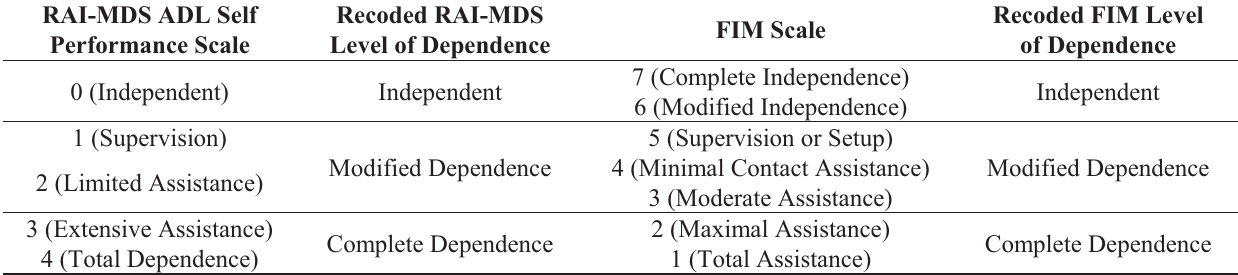
Table 1. Recoding method for RAI-MDS and FIM level of